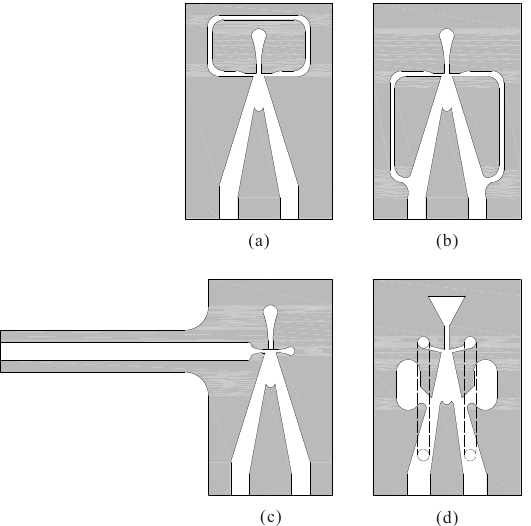
Figure 1. Four types of the bistable fluidic oscillators. ( a ) Relaxation bistable oscillator; ( b ) negative feedback bistable oscillator; ( c ) resonance ‐ channel fluidic oscillator; ( d ) output ‐ fed bistable oscillator.